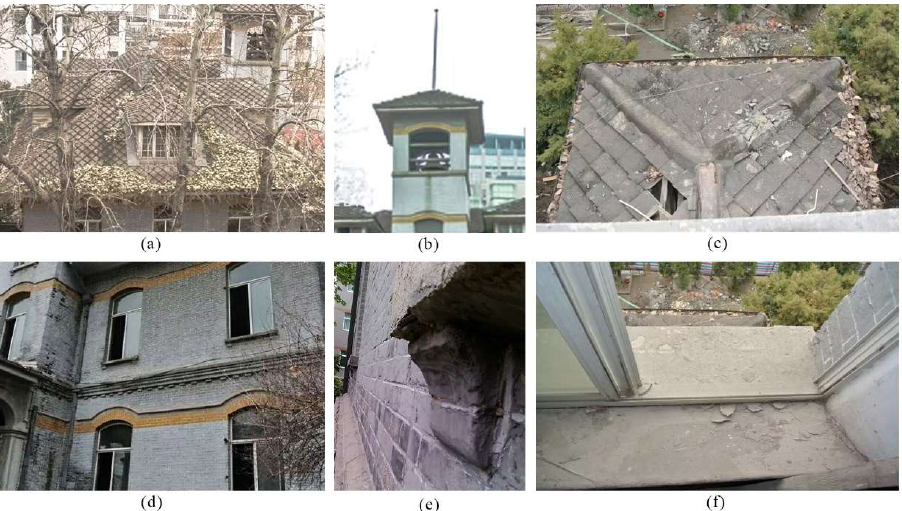
Buildings 2022 , 12 , x FOR PEER REVIEW Figure 7. The structure of the bell tower (source: author). Figure 7. The structure of the bell tower (source: author).